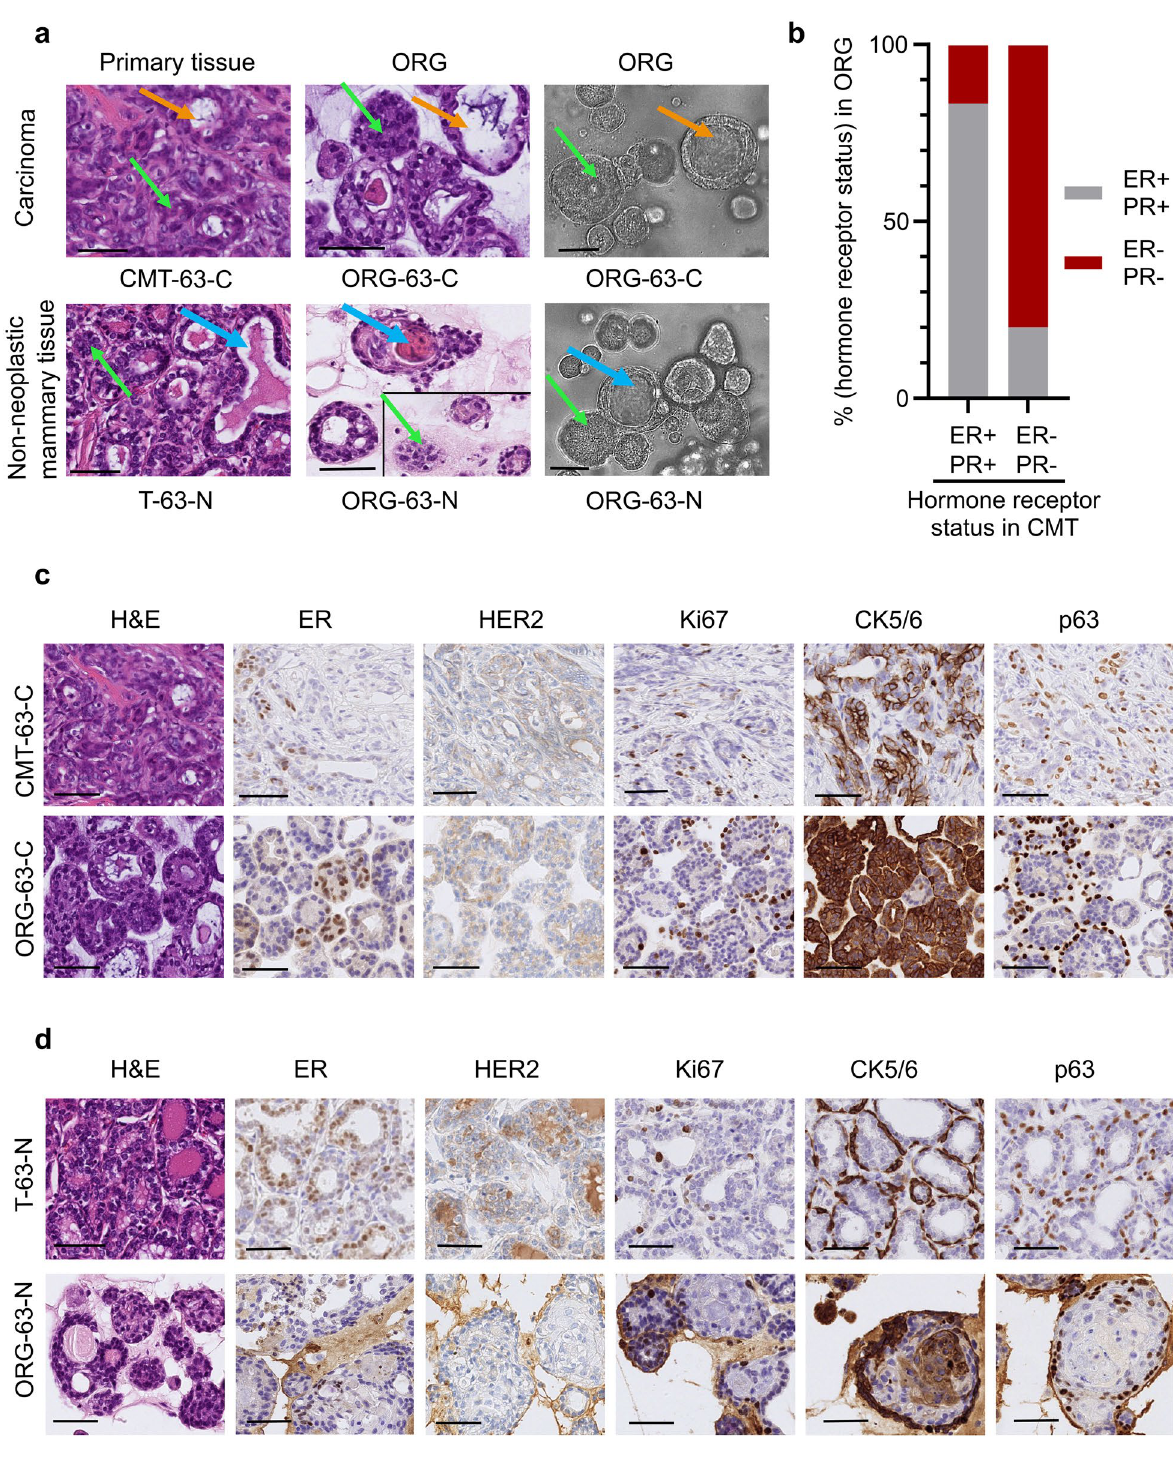
Figure 2. CMT organoids share important morphological characteristics and hormonal status with their primary tissue. ( a ) Representative images of H&E stainings of primary tissue (first column), patient-derived organoids (second column), and brightfield images (third column) of 3D organoids of normal mammary epithelium (bottom line) and of mammary tumor (top line) grown in Basement Membrane Extract. The green arrows indicate solid organoids, and the orange ones indicate cystic organoids; the blue arrows indicate luminal secretion. For comparison purposes, two different areas of the same scanned slide are represented for the H&E image of ORG-63-N. Scale bar, 50 μm. ( b ) Histogram showing the distribution of organoids that are hormone receptor- positive (brown) and negative (grey) grouped per original carcinoma receptor status. ( c ) Representative images of H&E stainings and immunohistochemical analyses of estrogen receptor (ER), human epidermal growth factor receptor 2 (HER2), Ki67 (marker of cell proliferation), cytokeratin (CK) 5/6 (luminal epithelial cells), and p63 (basal cells) in CMT-63-C tumor and tumor-derived organoids ORG-63-C (passage 3). Scale bar, 50 μm. ( d ) Representative images of H&E stainings and immunohistochemical analyses of estrogen receptor (ER), human epidermal growth factor receptor 2 (HER2), Ki67 (marker of cell proliferation), cytokeratin (CK) 5/6 (luminal epithelial cells), and p63 (basal cells) in normal mammary epithelium (T-63-N) and tissue-derived organoids ORG-63-N (passage 3). Scale bar, 50